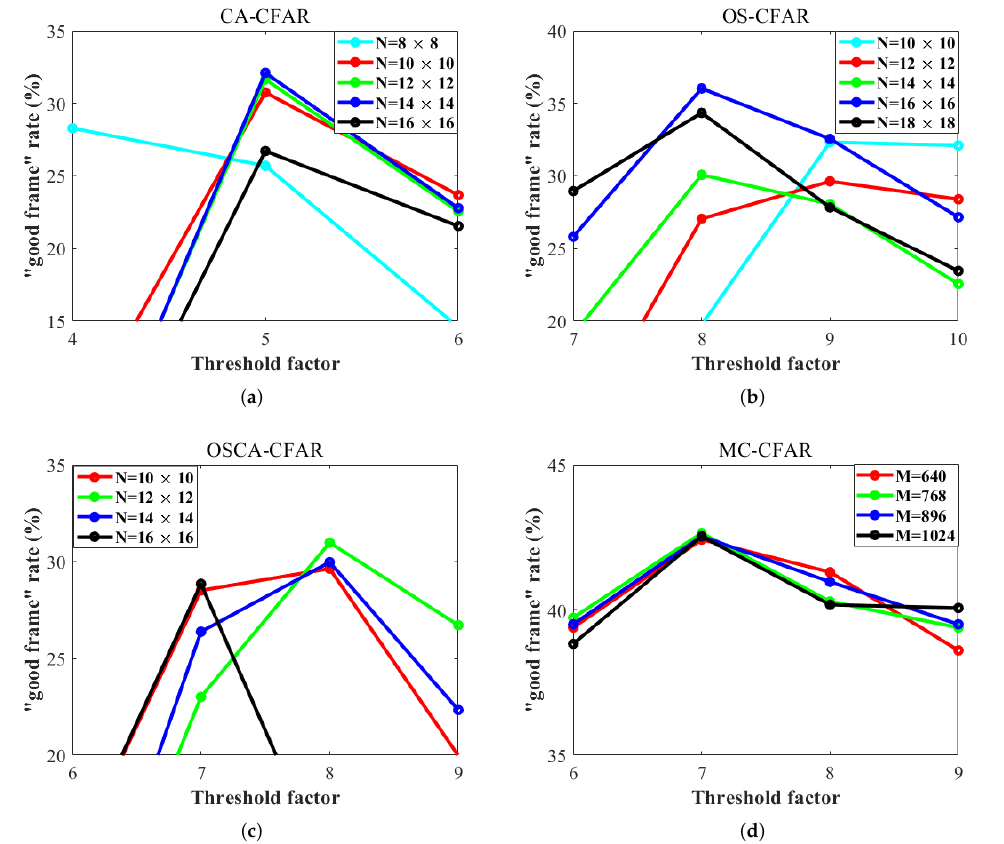
Figure 18. The relationship between algorithm performance and different parameter configurations at “ideal distance ”. ( a ) CA-CFAR test results. ( b ) OS-CFAR test results. ( c ) OSCA-CFAR test results. ( d ) MC-CFAR test results.